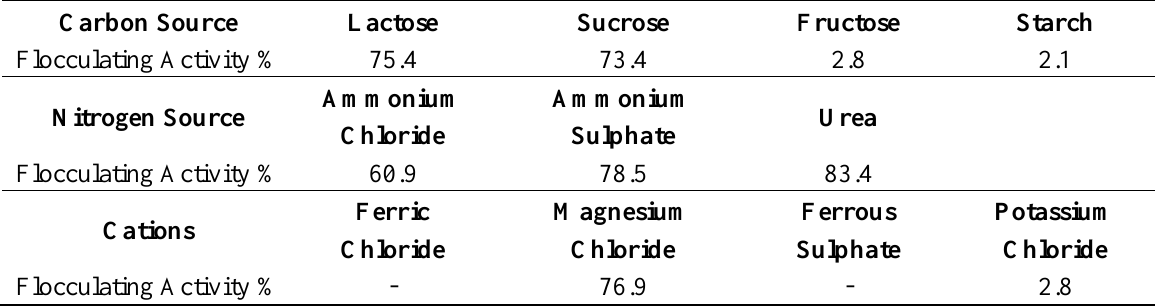
Table 1. Effect of constituents of culture medium on the production and flocculating activity of the bioflocculant produced by Arthrobacter sp. Raats.